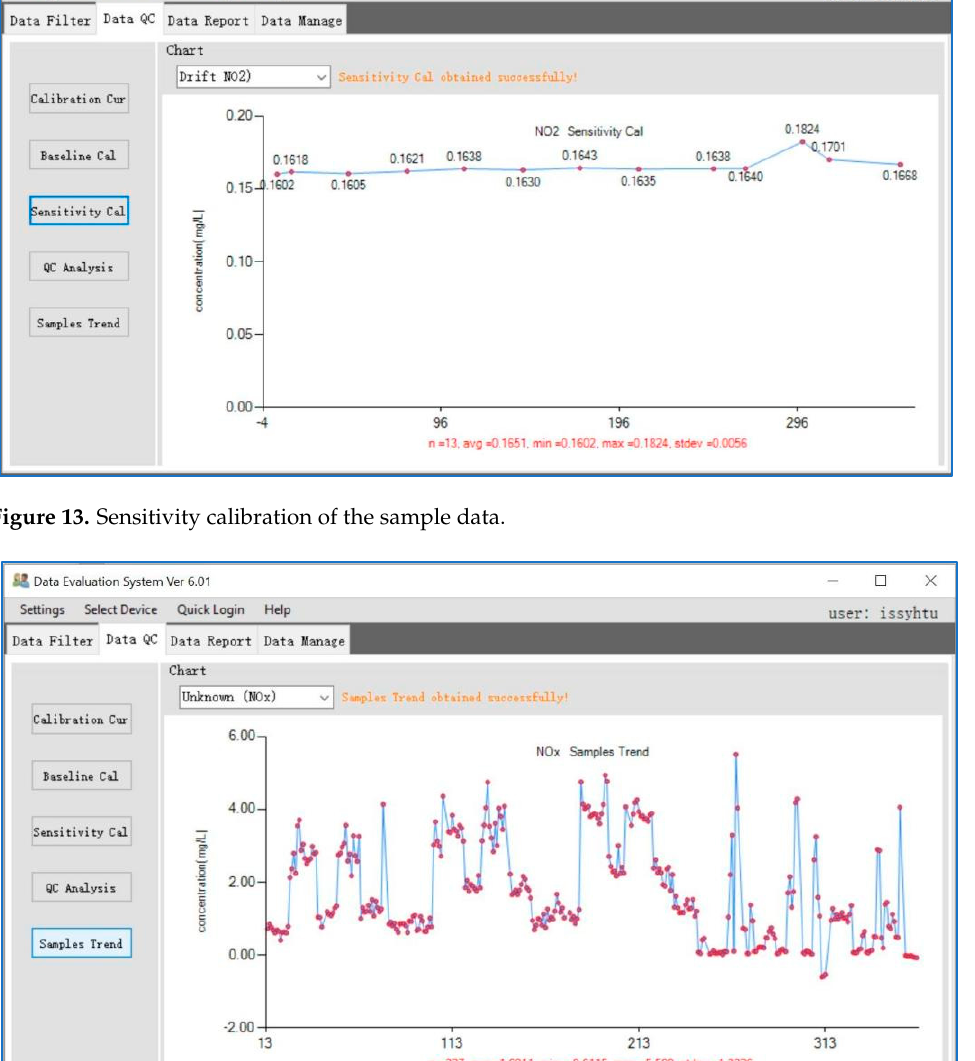
Figure 12. Baseline calibration of the sample data.